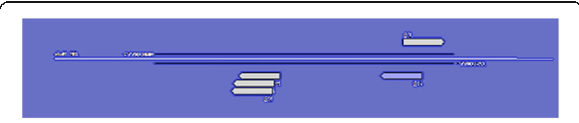
Fig. 1 Picture showing position of guide sequences for the selected sequence of a gene